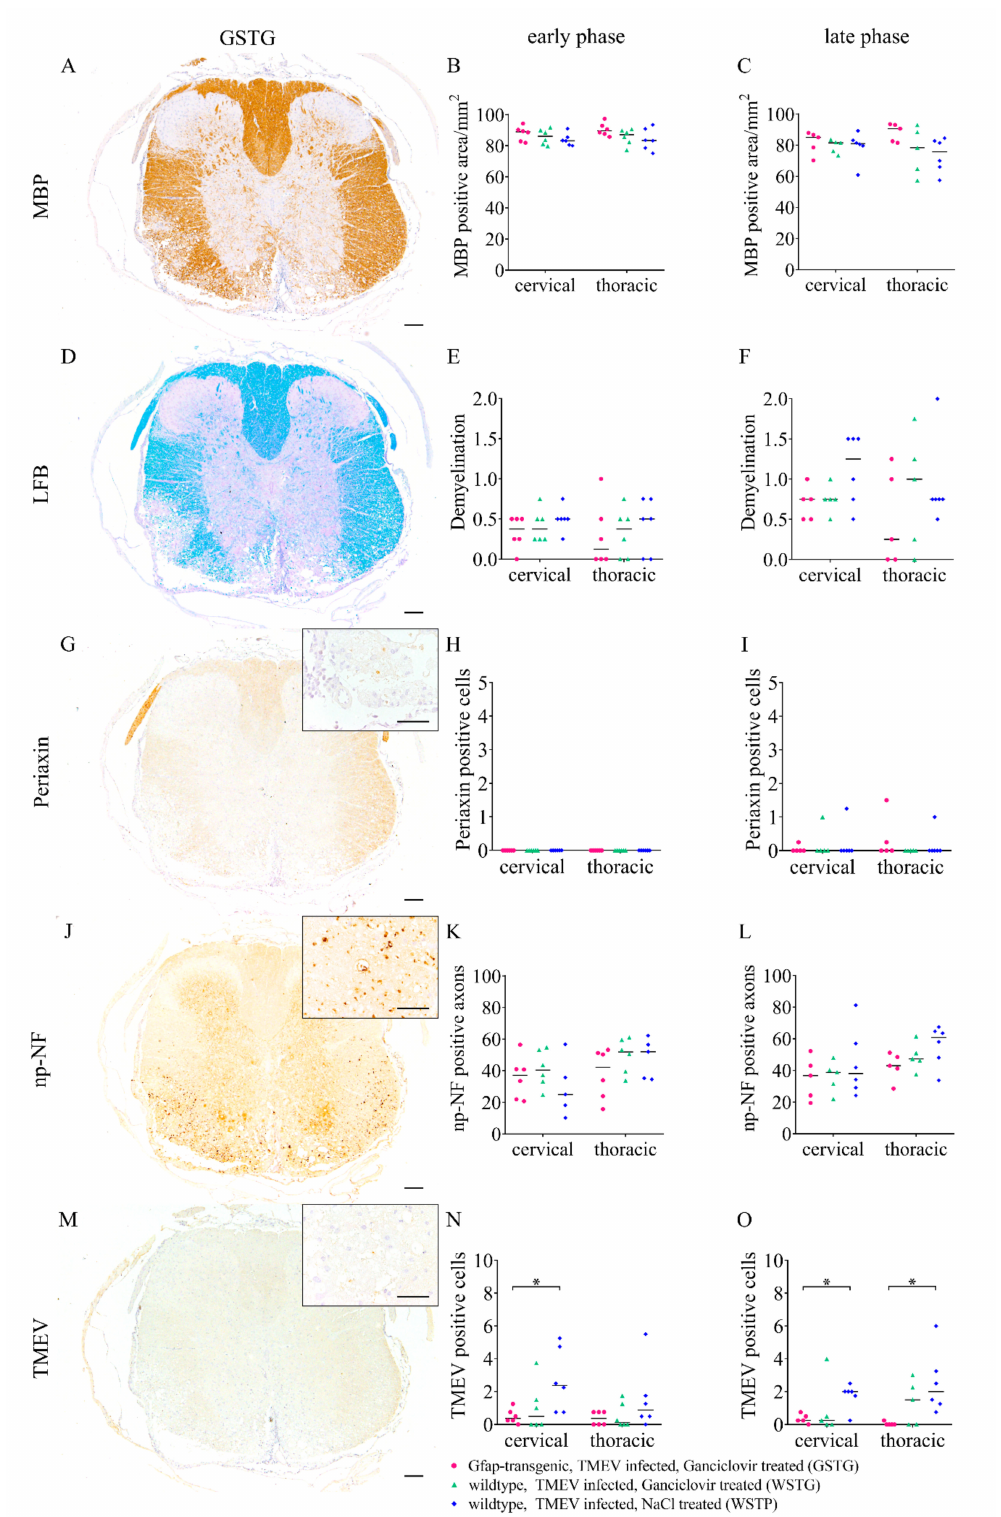
Figure 9. Quantification of demyelination, Schwann cell remyelination, axonal damage, and virus protein. Myelin basic protein (MBP; A–C ) immunohistochemistry and luxol fast blue-cresyl violet (LFB; D – F ) staining were used to quantify demyelination after astrocyte depletion. Accentuated in the ventral parts of the spinal cord white matter demyelination occurred in a variable degree in all